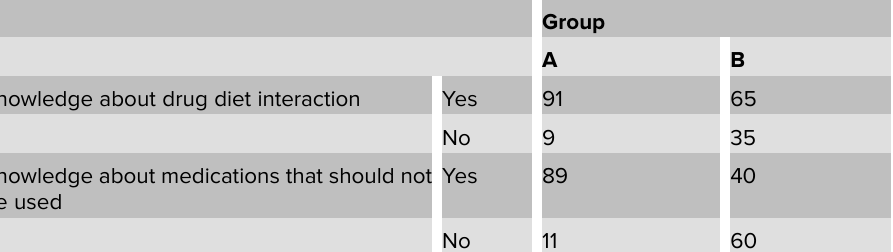
Table 1: The level of knowledge in INR-C (group A) and General-C (group B).